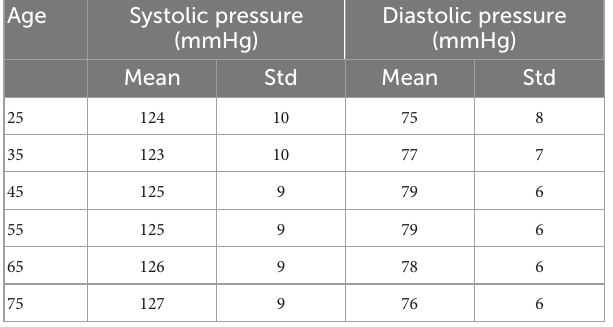
TABLE 2 Distributions of systolic and diastolic brachial pressure with